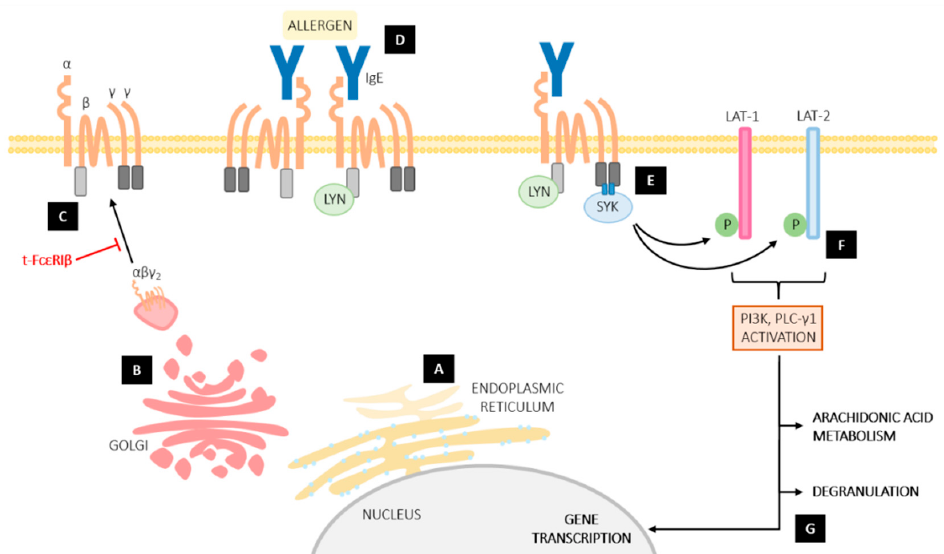
Figure 1. The role of Fc ε RI β in mast cell signaling pathways. ( A ) Synthesis of Fc ε RI α , β and γ - subunits takes place within the endoplasmic reticulum. Fc ε RI β facilitates appropriate glycosylation and folding of Fc ε RI α , and the γ -subunits permit export of the αβγ 2 tetrameric complex to the Golgi. ( B ) Full-length Fc ε RI β traffics the receptor complex to the cell surface, whereas t-Fc ε RI β , which is incapable of trafficking to the surface, prevents surface expression of Fc ε RI. ( C ) Once at the surface, full-length Fc ε RI β stabilizes the receptor complex. ( D ) Binding of IgE to the receptor increases receptor half-life at the surface. Allergen binding cross-links multiple Fc ε RI and induces receptor aggregation, which leads to phosphorylation of Fc ε RI β by LYN. ( E ) By binding LYN, Fc ε RI β amplifies phosphorylation of the Fc ε RI γ ITAMs, which leads to the recruitment and phosphorylation of SYK. ( F ) Phosphorylated SYK propagates intracellular signals by phosphorylating LAT and LAT2, which subsequently induce PI3K and PLC- γ 1 signaling cascades. ( G ) Ultimately, these signaling pathways culminate in proinflammatory gene expression and the release of cytokines and chemokines, arachidonic acid metabolism and eicosanoid production, and mediator release via degranulation. By preventing trafficking of Fc ε RI to the surface, t-Fc ε RI β inhibits the downstream cellular events of SYK phosphorylation, including mast cell mediator release. LYN, SRC family protein tyrosine kinase; ITAM, immunoreceptor tyrosine-based activation motifs; SYK, spleen tyrosine kinase; LAT-1, linker for activation of T cells; LAT-2, LAT-1 related adaptor; PI3K, phosphatidylinositol 3-kinase; PLC- γ 1, phospholipase C- γ